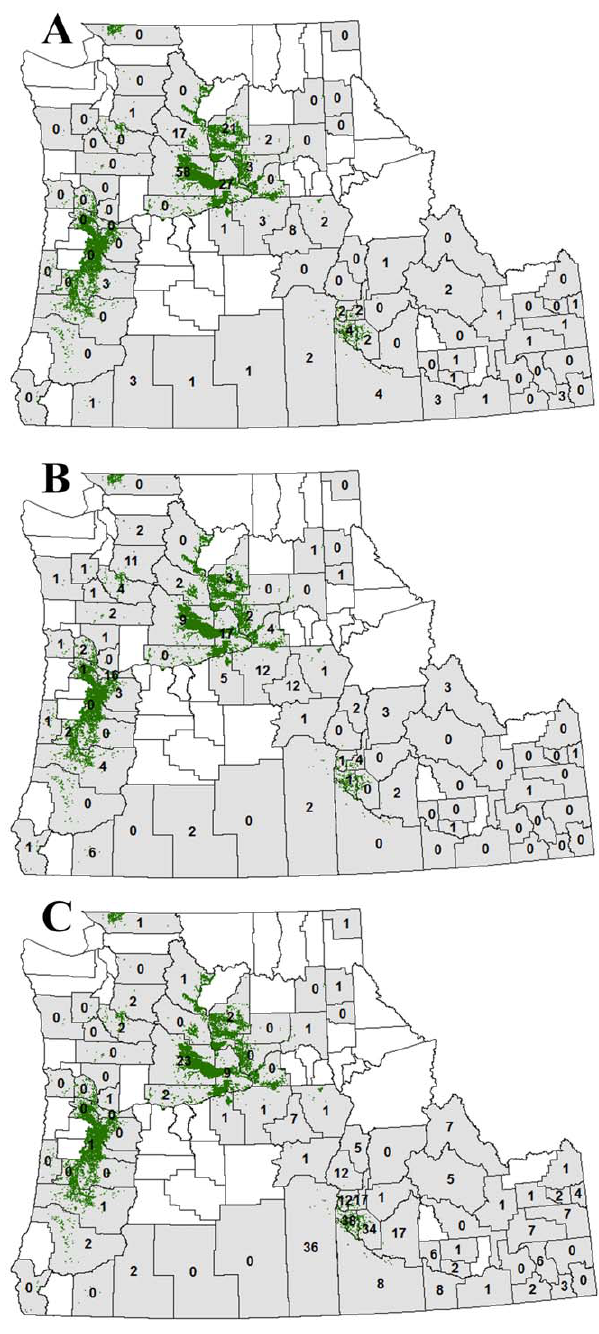
Figure 1. Land-use and the prevalence of West Nile virus infection. Number of West Nile virus (WNV) infections in (A) horses, (B) birds, and (C) humans from 2007 to 2010 over Idaho, Oregon, and Washington States. Counties shaded gray had at least one WNV case detected in any species over this period, with the numbers indicating the number of infections in each organism(s). Land covered by orchard habitats is shown in green. doi:10.1371/journal.pone.0055006.g001 While American robins and house sparrows benefited from orchard habitats, we found no evidence that land-use or climate affected total bird abundance or species richness (Table 1). Thus,